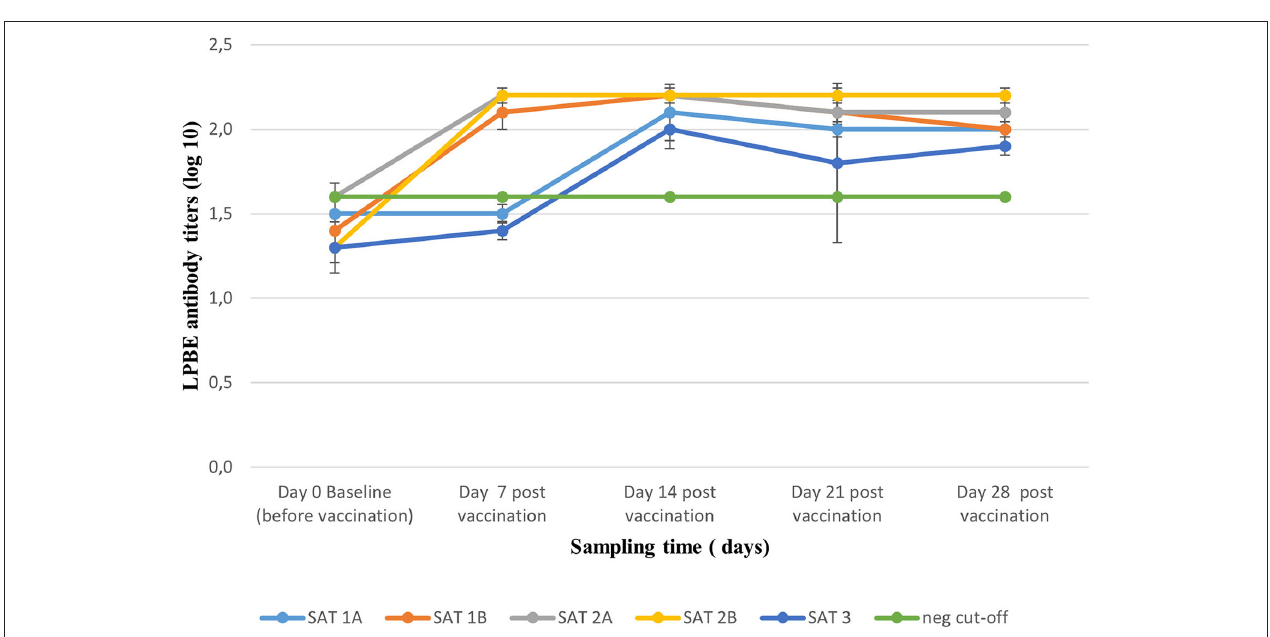
FIGURE 2 | Mean ( ± SD) antibody titers (liquid phase blocking ELISA) elicited by full-dose vaccination with the five monovalent vaccines, monitored weekly over a period of 28 dpv. The green line represents the cut-off titer of 1.6 log10 based on day 0, pre-vaccination titers.